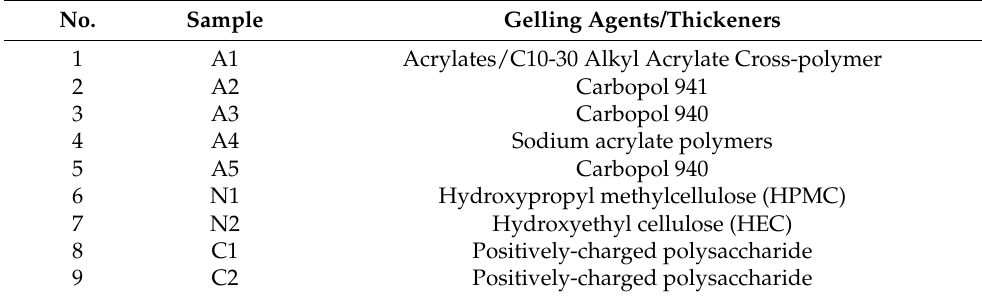
Table 1. Type of gelling agents/thickeners in lubricating gel